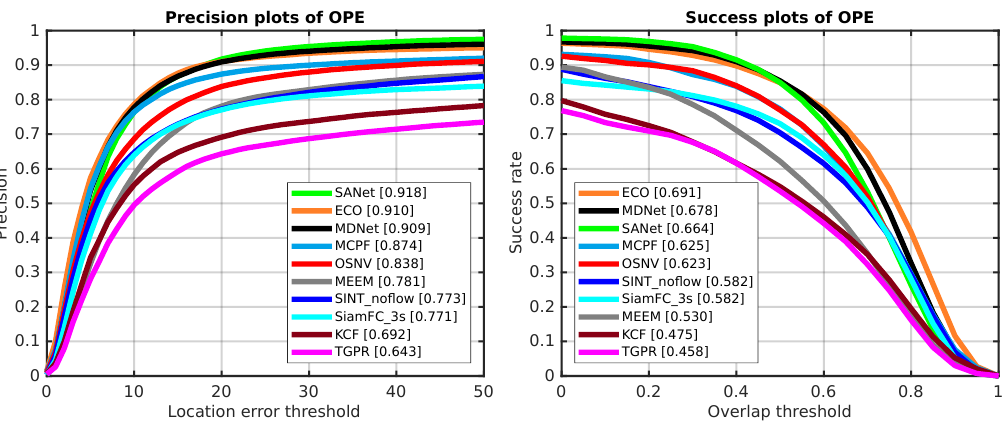
Figure 7. The OPE results of 10 tracking algorithms on OTB-2015. The left side is precision plots and the right side is success plots, which are both evaluated on OTB-2015.